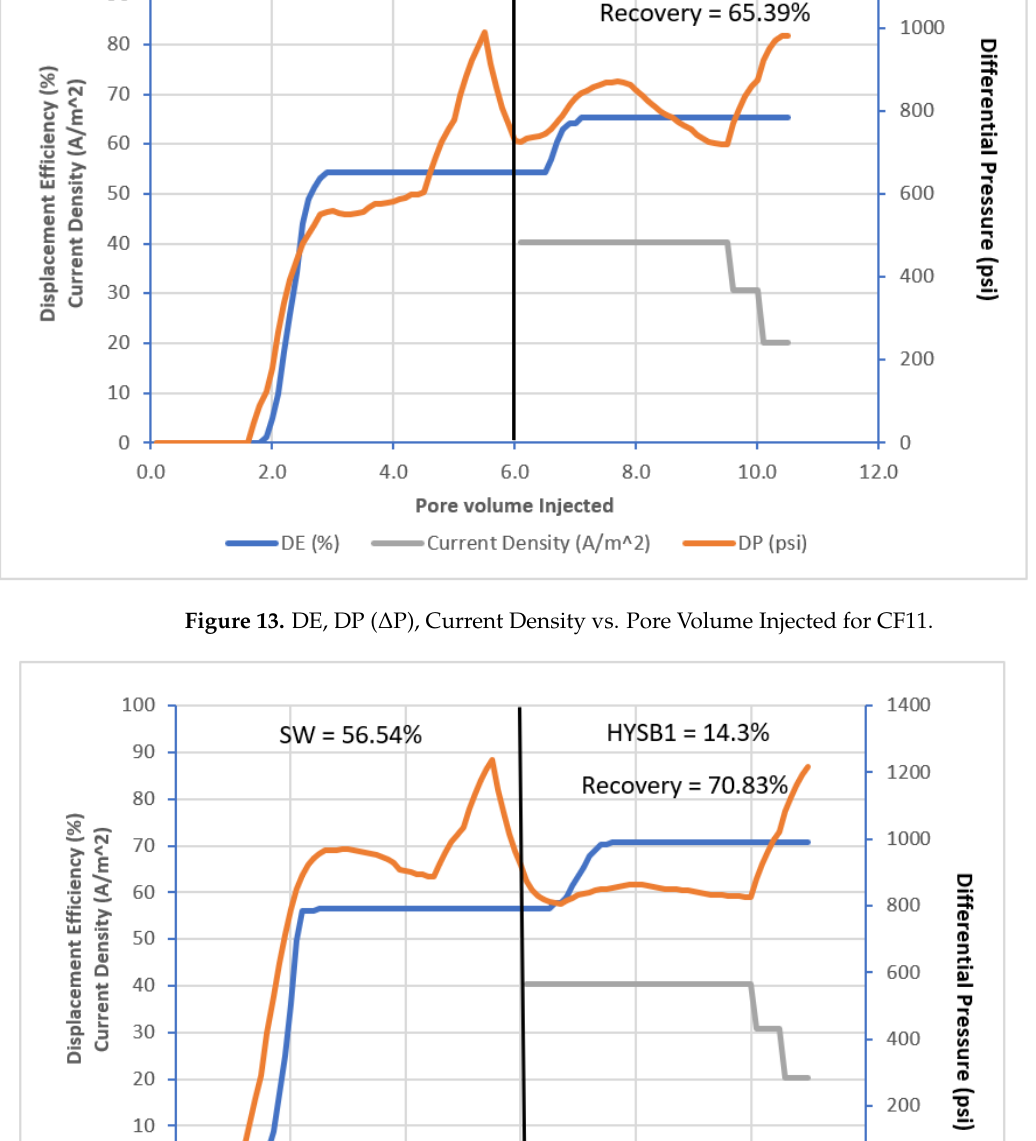
Table 19. Summary of CF12.